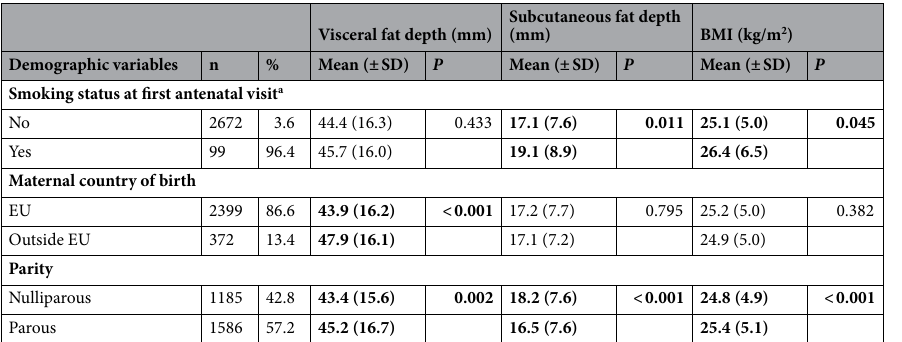
Table 2. Comparison of visceral fat depth, subcutaneous fat depth, and early pregnancy BMI between groups defined by demographic and clinical parameters. Data were analyzed using t-tests. Significant results are in bold. a After imputation of data on smoking status. BMI, body mass